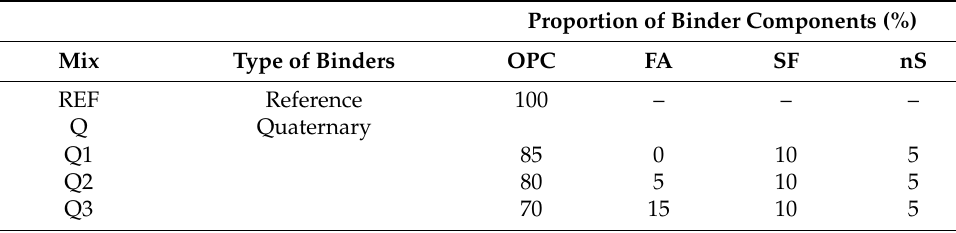
Table 6. Various mix proportions of OPC and SCMs used for the experimental